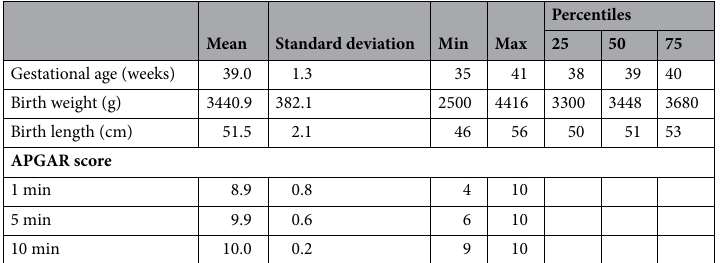
Table 1. Detailed information of the N = 45 participants. For participant with ID 28 no APGAR scores could be obtained. The APGAR score 37 was developed to evaluate a newborn’s health condition and the potential need of neonatal care based on five categories (Appearance, Pulse, Grimace, Activity, Respiration). A score ≥ 7 is considered normal, scores ranging between 4 and 6 are classified as fairly low, and scores ≤ 3 as critically low 37,38 . The APGAR assessment is routinely applied three times, i.e. 1, 5, and 10 min after